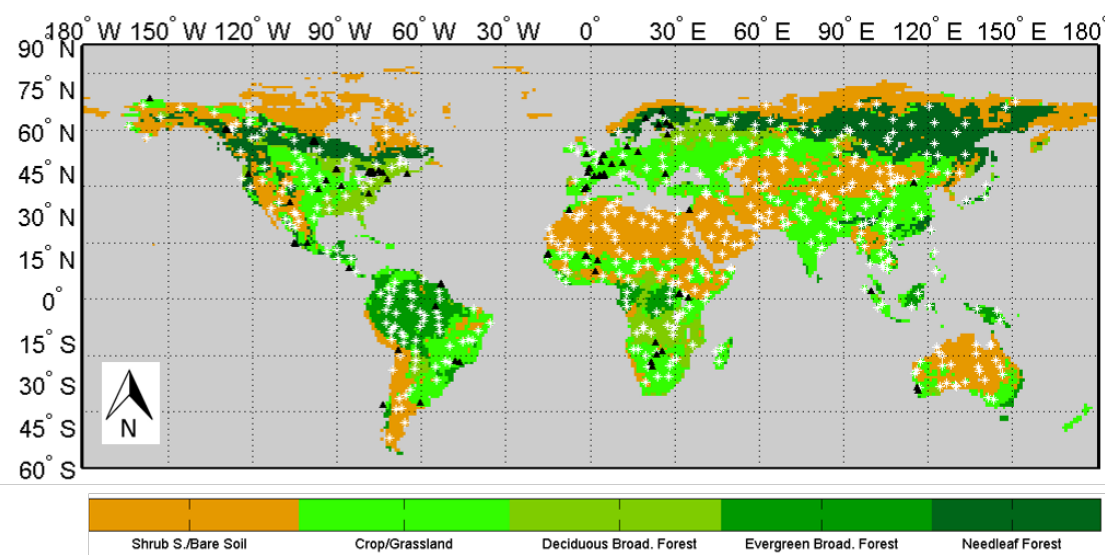
Figure 1. BELMANIP2.1 site (white stars) and DIRECT site (black triangles)